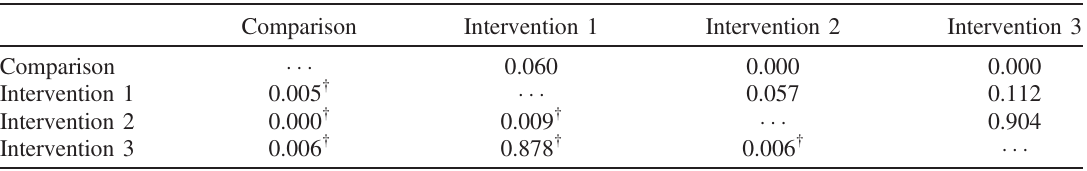
TABLE IV. The p values (from ANOVA) for the comparison of students ’ performance on the friction problem between different groups in the calculus-based and algebra-based courses. a The algebra-based course is indicated by the † symbol.